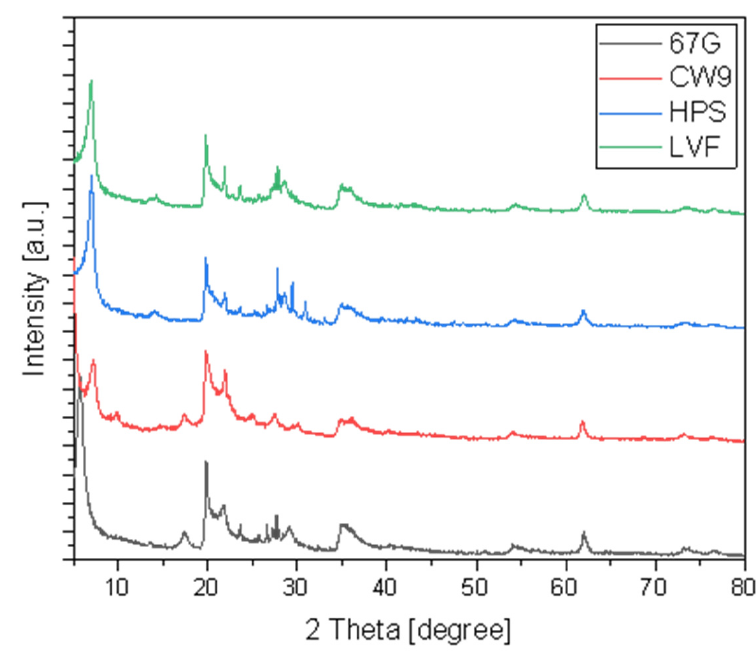
Figure 2. XRD patterns of different types of nanoclay.